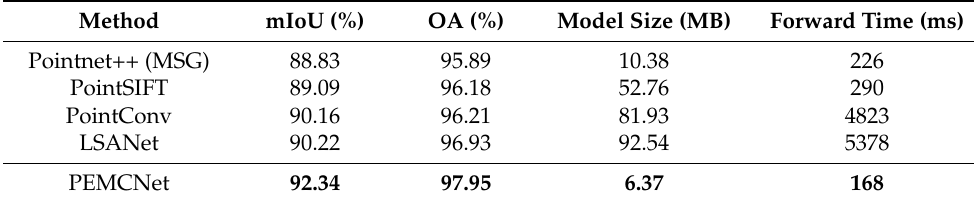
Table 1. Quantitative classification performance of different networks on US3D dataset.